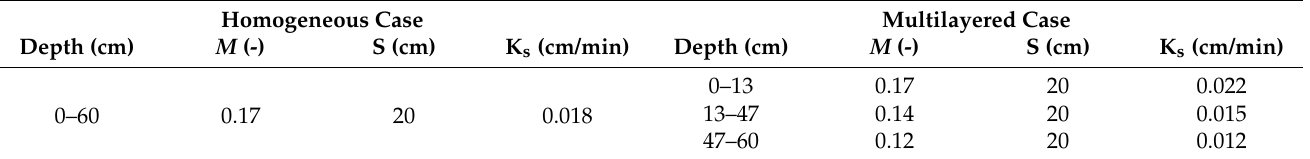
Table 2. Parameters of the ponding infiltration experiment